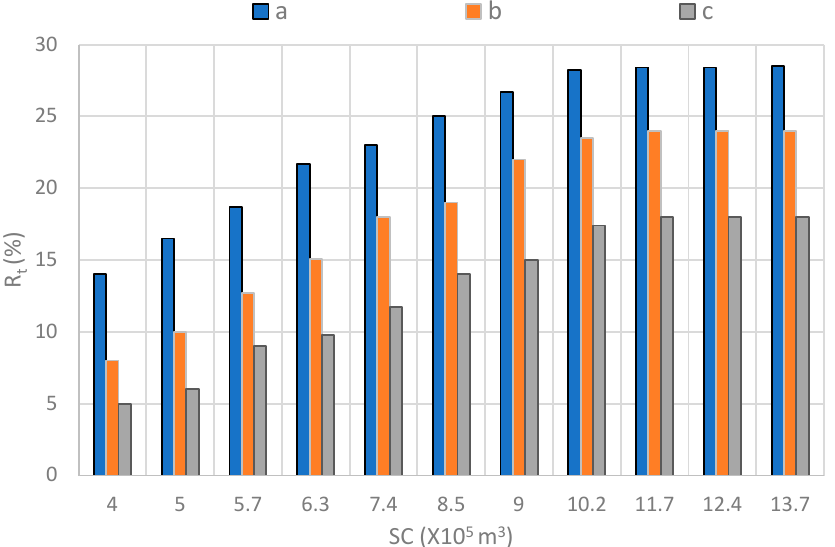
Figure 3. The percentage of time-based reliability (R t )vs storage capacity (SC) for (a) wet, (b) average, and (c) dry-year climate scenarios.